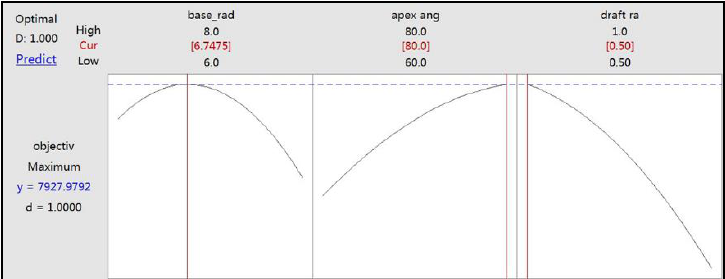
Figure 10. Surface diagram of objective function vs. cone angle and base radius.